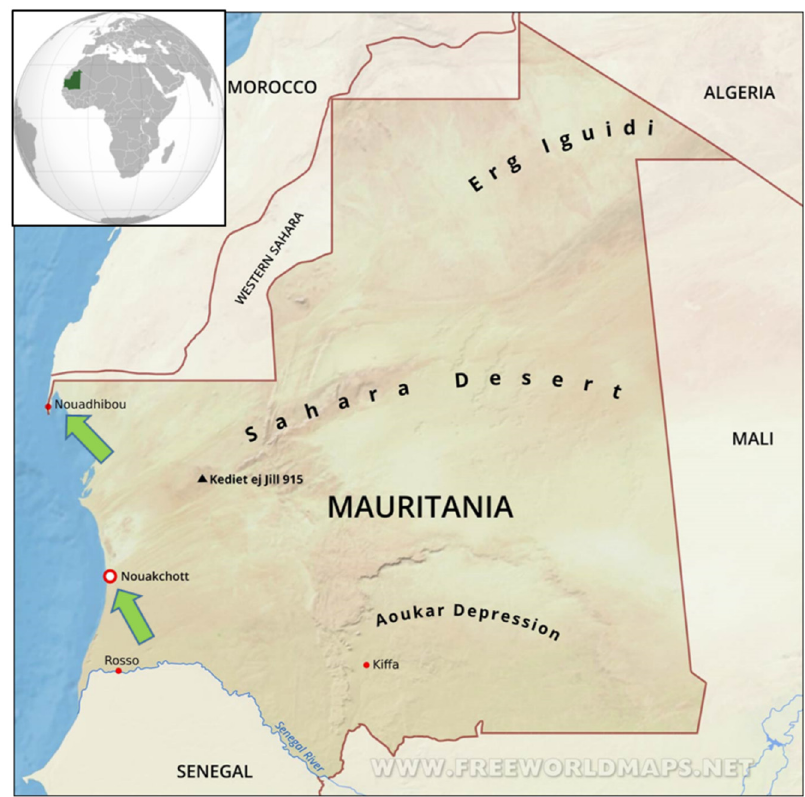
Figure 1. Representation of Mauritania, West Africa. The two localities in which the bed bugs were collected in domestic settings, between September 2021 and October 2021, are indicated with green arrows (from North to South: Nouadhibou and Nouakchott).